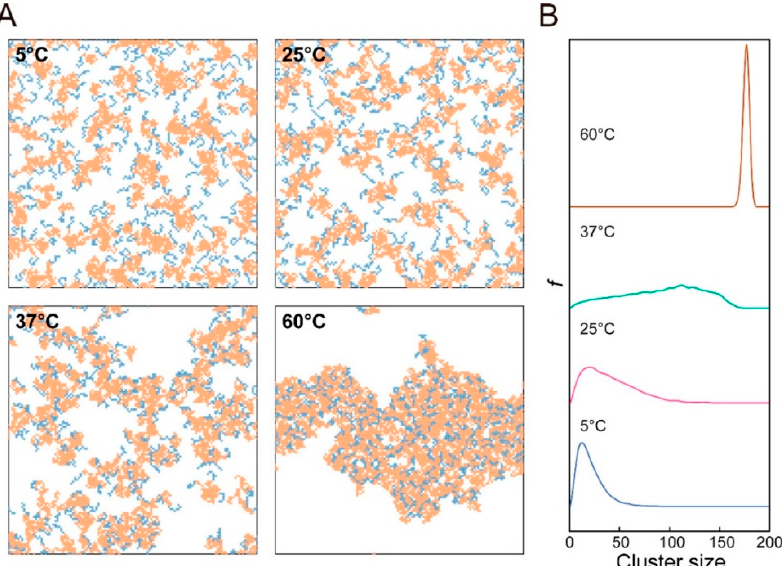
Figure 3. Mesoscopic structure of PEG–PLGA in water at different temperatures revealed by Monte Carlo simulation: ( A ) typical snapshots of the systems and ( B ) corresponding cluster size distribution.